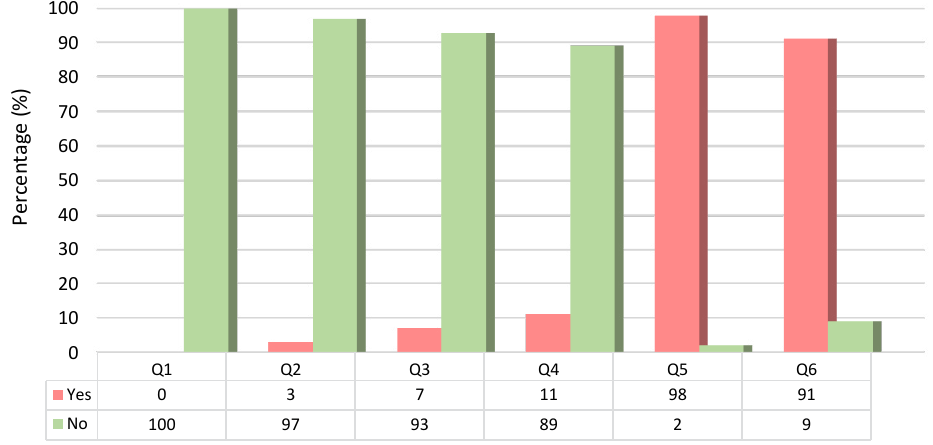
Fig. 14: Frequency percentages for the number of respondents to questions based on answers; part 2